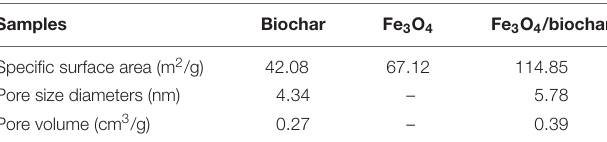
TABLE 1 | Brunauer–Emmett–Teller (BET) analysis of biochar, Fe 3 O 4 , and